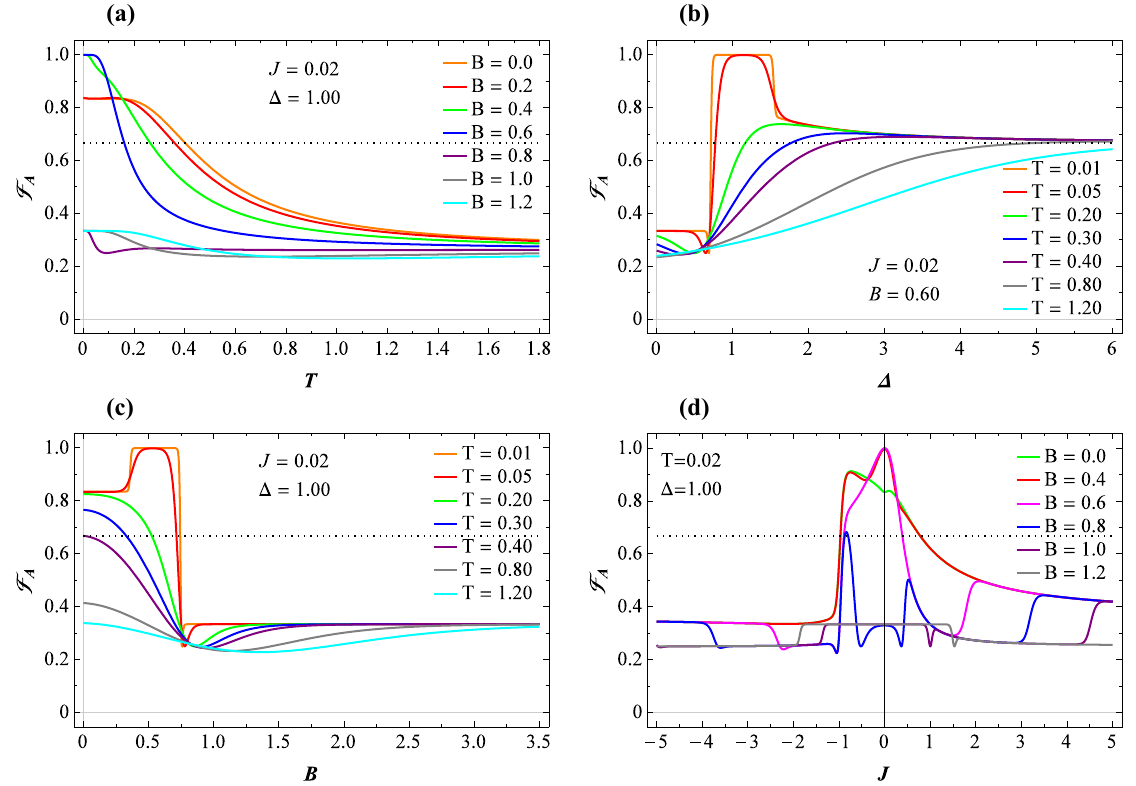
Figure 5. ( a ) The average fidelity F A versus temperature, assuming J = 0.02 , (cid:31) = 1 , and several fixed values of the magnetic field. ( b ) F A as a function of anisotropy (cid:31) for fixed J = 0.02 , B = 0.6 , and different values of the temperature. ( c ) Field dependence of F A for various temperatures, where other parameters have been taken as J = 0.02 and (cid:31) = 1 . ( d ) the same function at low temperature T = 0.02 against the coupling constant J when different fixed values of the magnetic field are considered such that (cid:31) = 1 . Dotted lines indicate the classical limit of fidelity